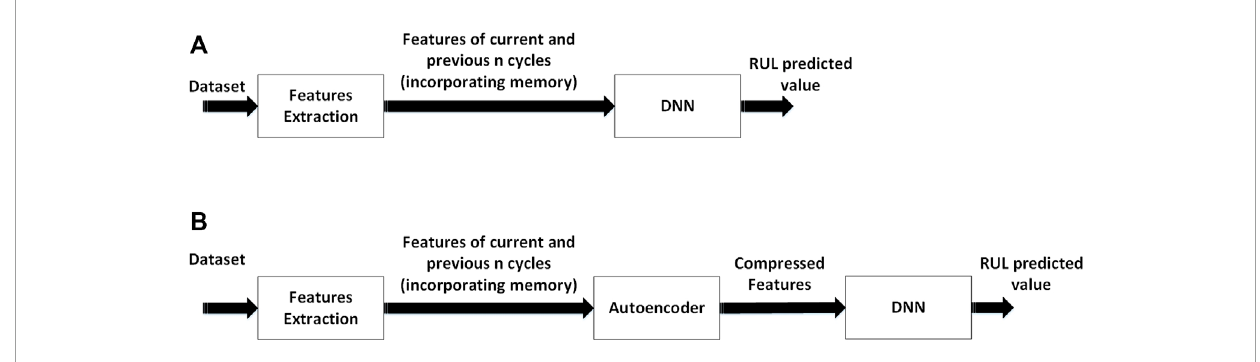
FIGURE 1 The proposed frameworks (A) DNN with memory features (DNNwMF) and (B) autoencoder with DNN with memory features